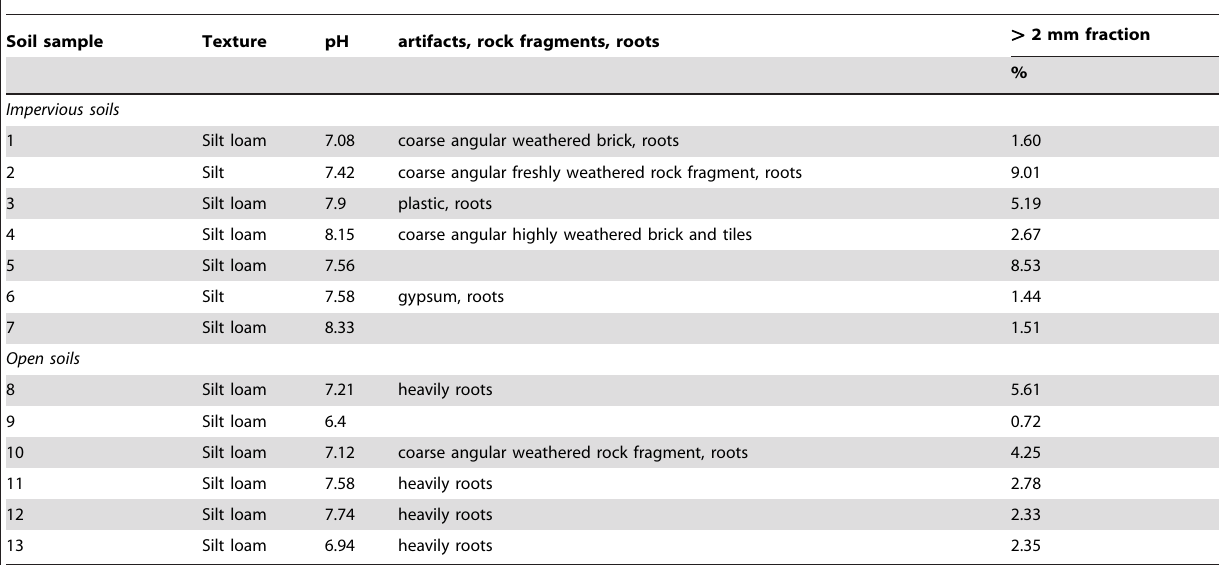
Table 3. Outline description for the urban soils (0–20 cm) selected in our study.